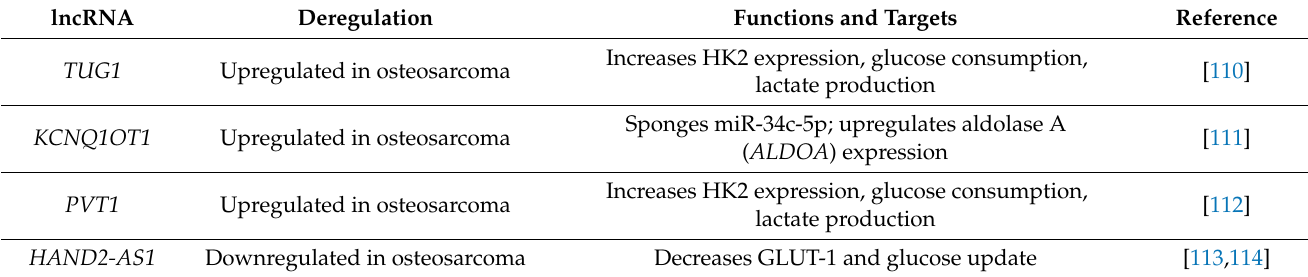
Table 7. Examples of lncRNAs implicated in glucose metabolism alteration in